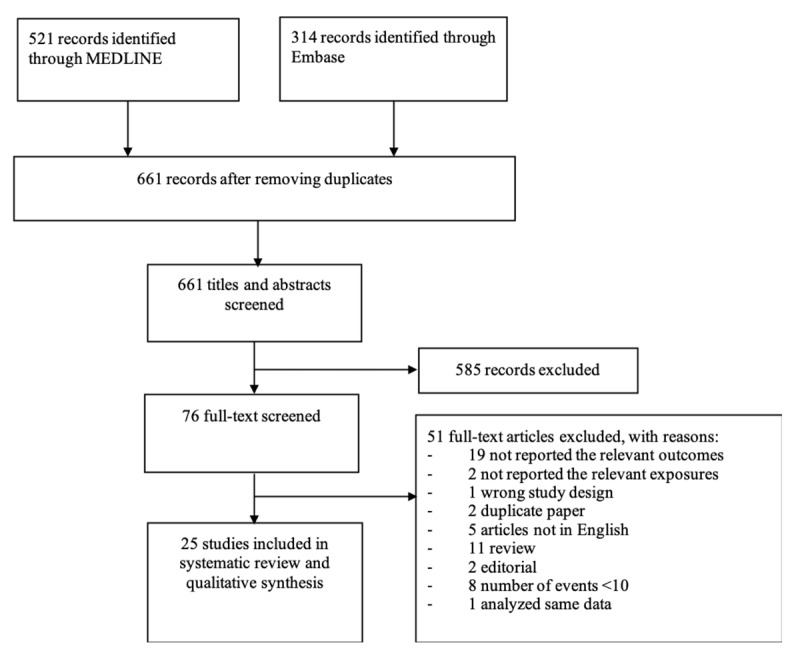
Flow chart of study selection.